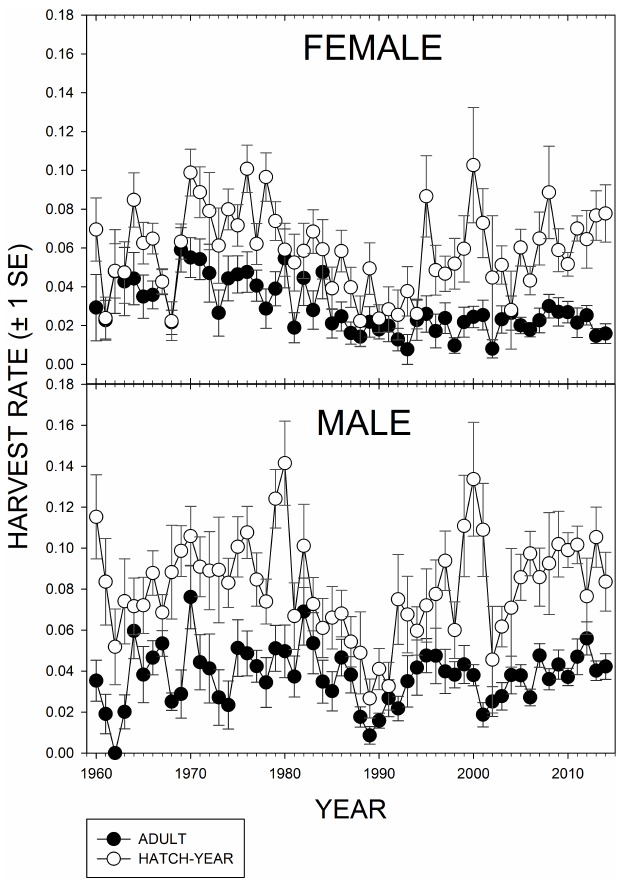
Fig. 8. Annual harvest rates of Northern Pintail ( Anas acuta ) banded in southern Alberta and Saskatchewan, Canada (≤ 54° N latitude) from